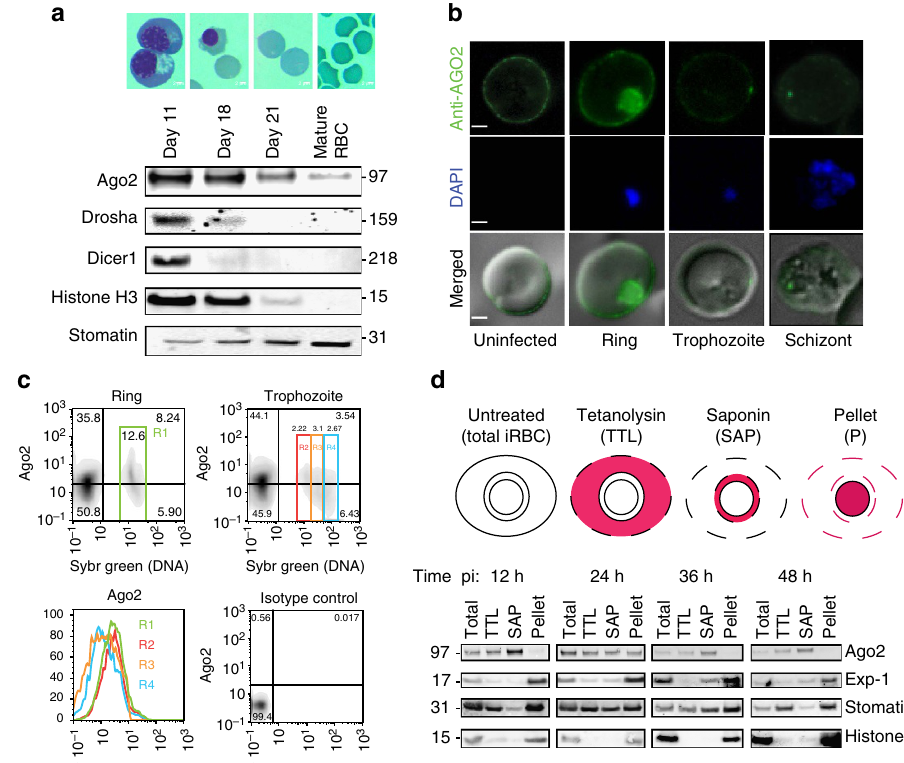
Figure 2 | Detection of human Ago2 in RBCs and iRBCs. ( a ) Expression of RNAi machinery during RBC development. Cell lysates from different developmental stages of erythropoiesis were prepared (day 11: basophilic and polychromatic erythroblasts, day 18: orthochromatic erythroblasts and reticulocytes, day 21: reticulocytes and normocytes; representative images are shown). Ago2 is detectable in mature RBCs while dicer, drosha (and human histone H3) are not present. Stomatin is present in all preparations. ( b ) IFA of Ago2 in RBCs and iRBCs. Ago2 is localized to the RBC periphery in uninfected and infected RBCs, however, labelling is reduced in later parasite stages. Notably, ring stage parasites also show Ago2 accumulation in the parasite. Scale bar; 1 m m. ( c ) Flow cytometry analysis of Ago2 labelling in RBCs and iRBCs. Uninfected RBCs and iRBCs were gated based on SYBR staining (nuclear content, n ) and Ago2 labelling. Young iRBCs (rings, and trophozoites with n ¼ 1) show the highest Ago2 labelling, confirming IFA data. ( d ) Sequential fractionation of purified infected parasites analysed by western blot. iRBC samples were collected at four time points post invasion, separated from uninfected RBCs and fractionated. The host cytosol was released with 1 HU of tetanolysin (TTL) and subsequently the PV contents were released with 0.035% of saponin (SAP). The pellet contains parasite material and host membranes while the TTL supernatant contains RBC cytosol and the SAP supernatant contains soluble parasitophorous vacuole material. The parasitophorous vacuole membrane marker PfExp-1 and parasite nuclear histone H3 are detectable in the pellet fraction across the asexual parasite cycle. Ago2 is present in cytosol (SAP, TTL) across the cycle but only present in the pellet fraction in early parasite stages, supporting the dynamic distribution observed by IFA. Host stomatin is present in cytosol (SAp, TTL) and membranes (pellet) throughout the cycle. Data are representative of three independent experiments. pi: post